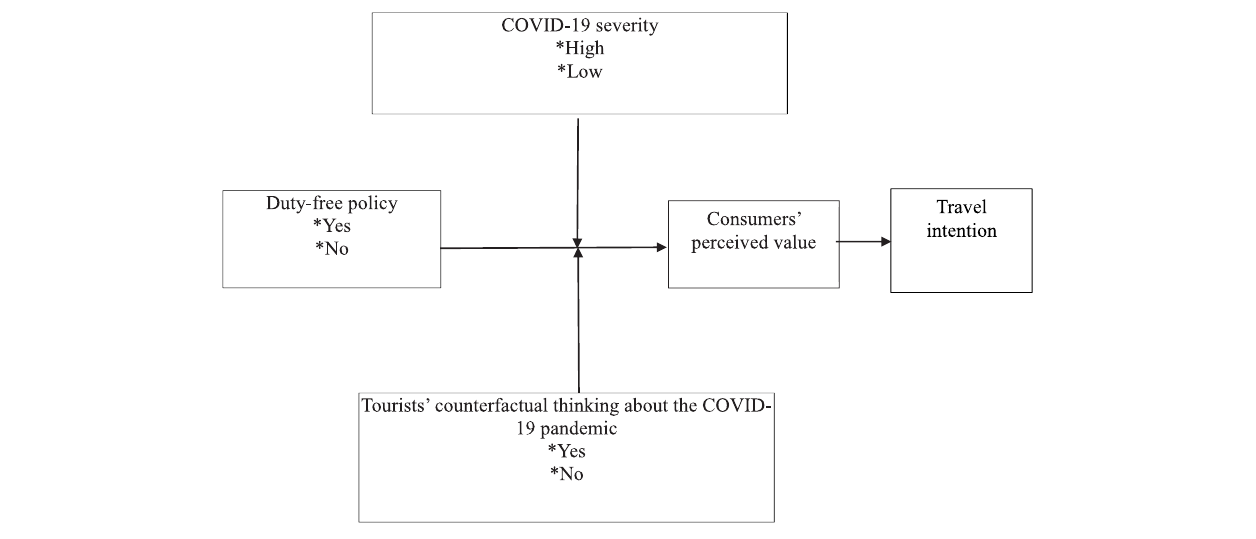
FIGURE 1 | Proposed research